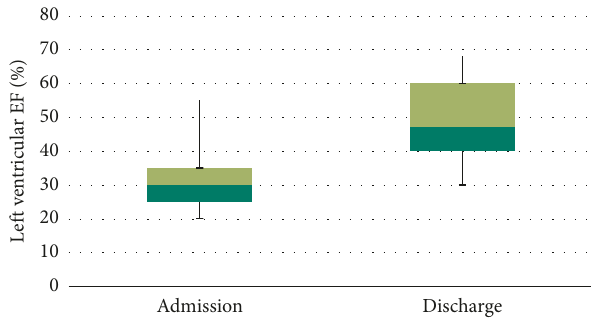
Figure 1: Left ventricular ejection fraction (%) on admission and on discharge in the TTS group.